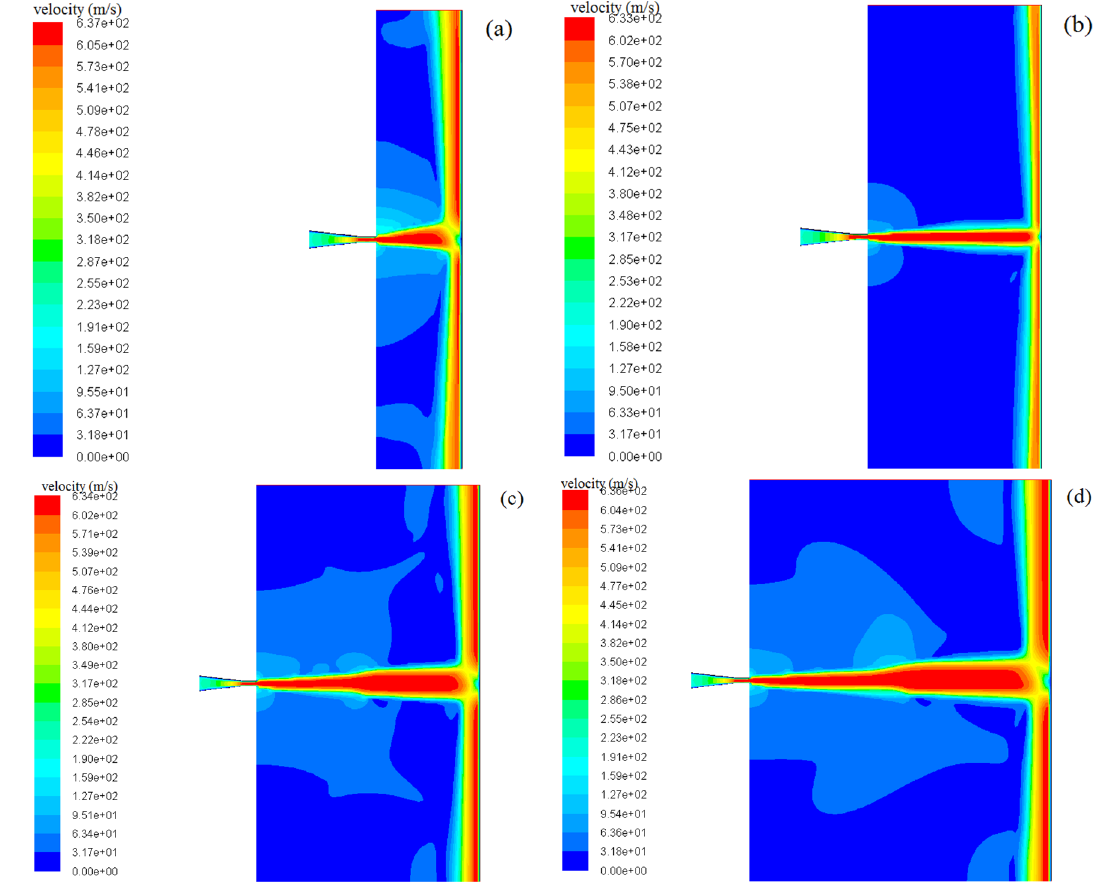
Figure 16. Predicted velocity cloud chart under various stand-off distances ( a ) 15 mm; ( b ) 30 mm; ( c ) 45 mm; ( d ) 60 mm.